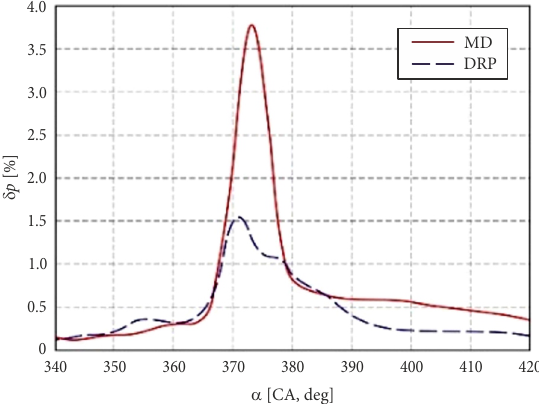
Figure 4. Mean cycle-by-cycle differences in cylinder pressure vs CA for MD and DRP (3000 rpm / 50 N ⋅ m)